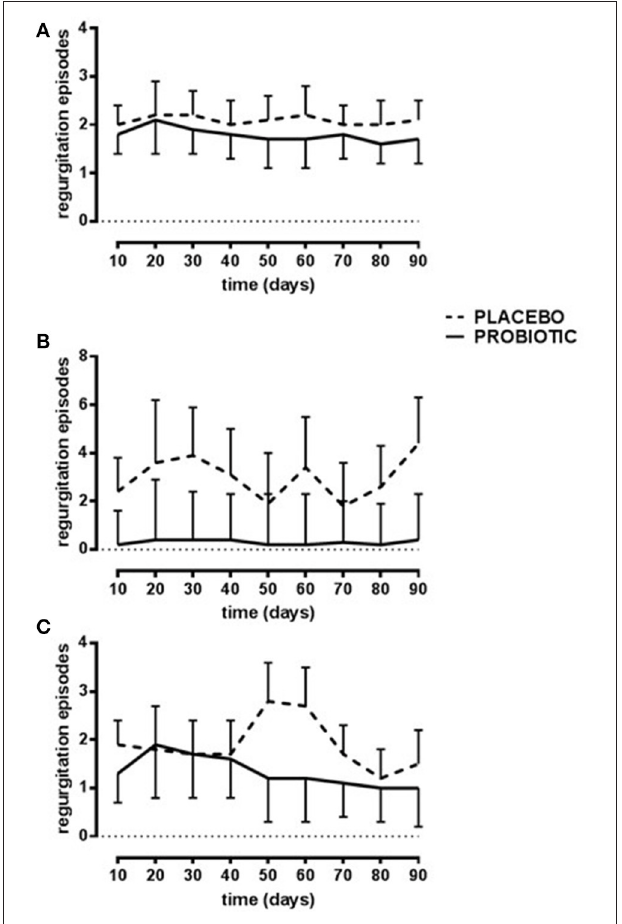
FIGURE 2 | Number of daily regurgitations. Probiotic group (continuous line) and placebo group (dotted line). Breast-fed newborns (A) ; Bottle-fed newborns (B) ; Mixed-fed newborns (C) . Data are expressed as marginal mean ± SEM. Data are significant in interaction ( p < 0.04; model 3). The residuals are not homogenous across the groups.